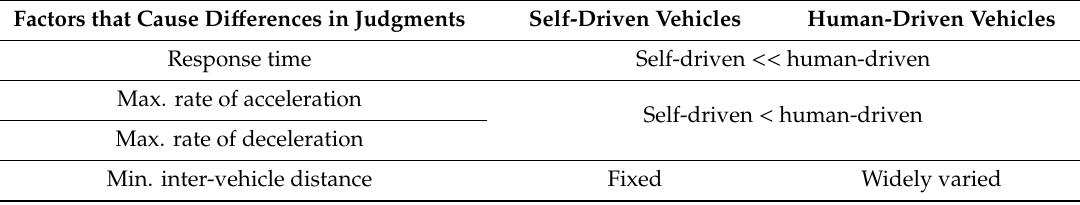
Table 1. Factors that cause di ff erences in judgments between self-driven and human-driven vehicles. Factors that Cause Di ff erences in